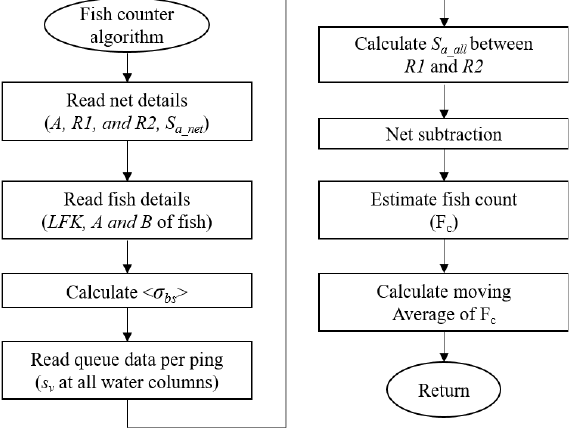
Figure 11. Flowchart of fish counting algorithm used in